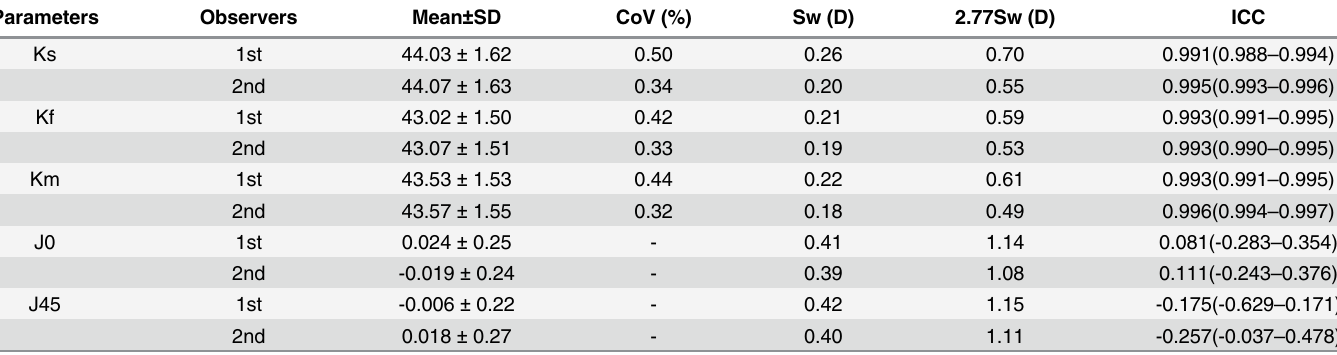
Table 4. The intraobserver repeatability of Ks, Kf, Km, J0 and J45 obtained by iTrace. (Note: D: diopter, SD: standard deviation, Sw: within-subject standard deviation, CoV: within-subject coefficient of variation, ICC: intraclass correlation coefficient.)